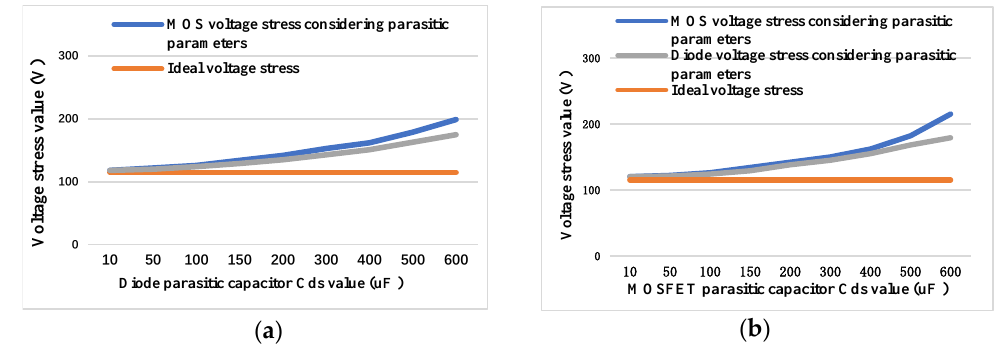
Figure 11. Comparisons of the influence of various parasitic parameters on the output gain. ( a ) The effects of the Cds on the switching stress. ( b ) The effects of C D on switching stress.